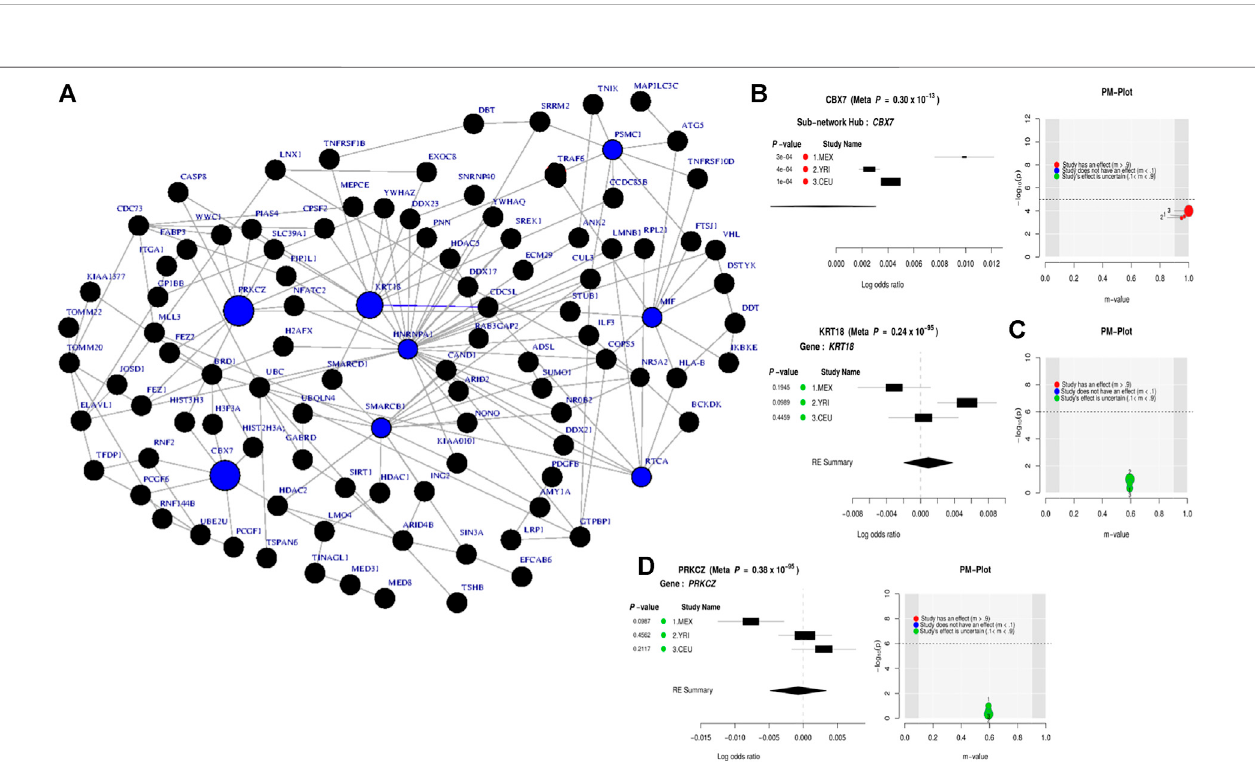
FIGURE 2 | Combined statistical outcomes at the subnetwork level, explaining causality relationship between the simulated phenotype and population variation population based on 3 independent simulated GWAS datasets from CEU, YRI, and MEX, respectively. (A) Top signi fi cant meta-analysis-based sub-network from ancMETAwhere nodes in blue colour denote critical hub and genes associated tothe simulated causal SNPs. The size ofanode denotes its statistical signi fi cance from small to large. (B-D) Forest plot of three gene-hub from the top 3 meta-analysis sub-networks produced from ancMETA.